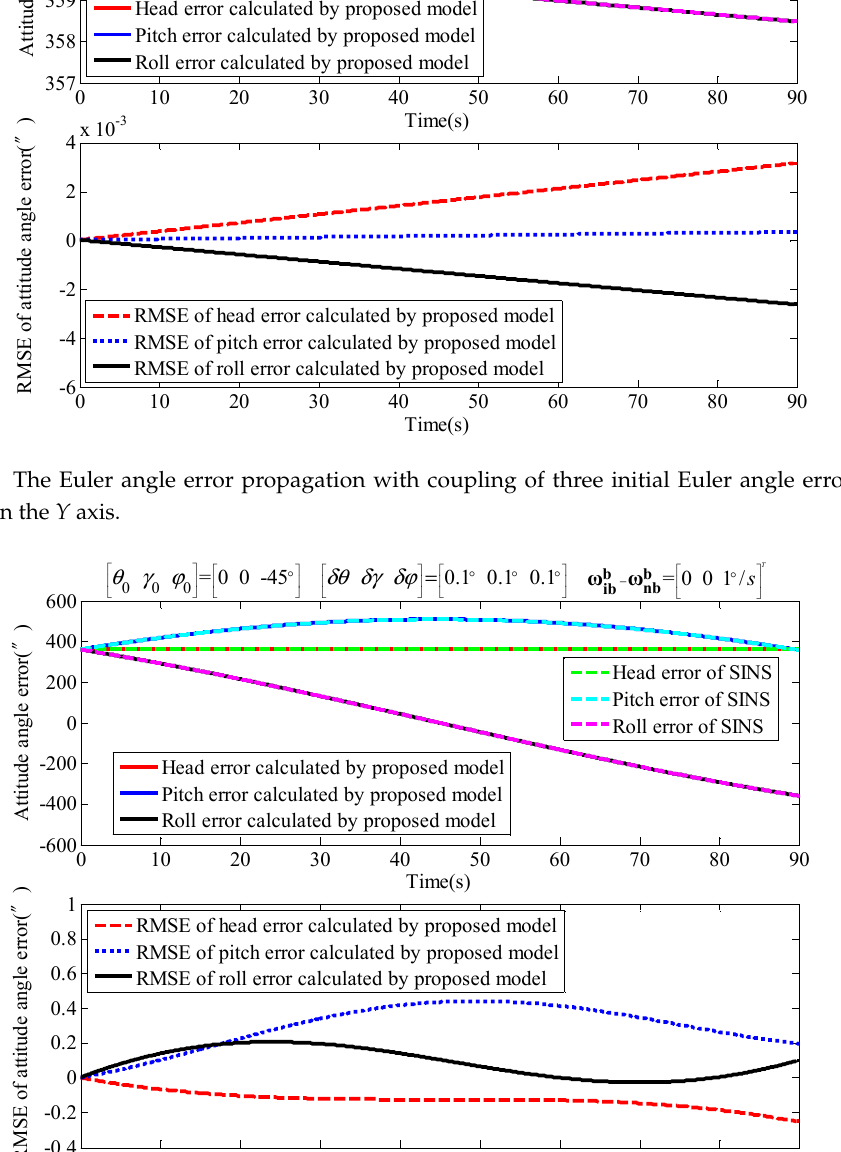
Figure 10. The Euler angle error propagation with the coupling of three initial Euler angle errors and rotation in the Z axis.